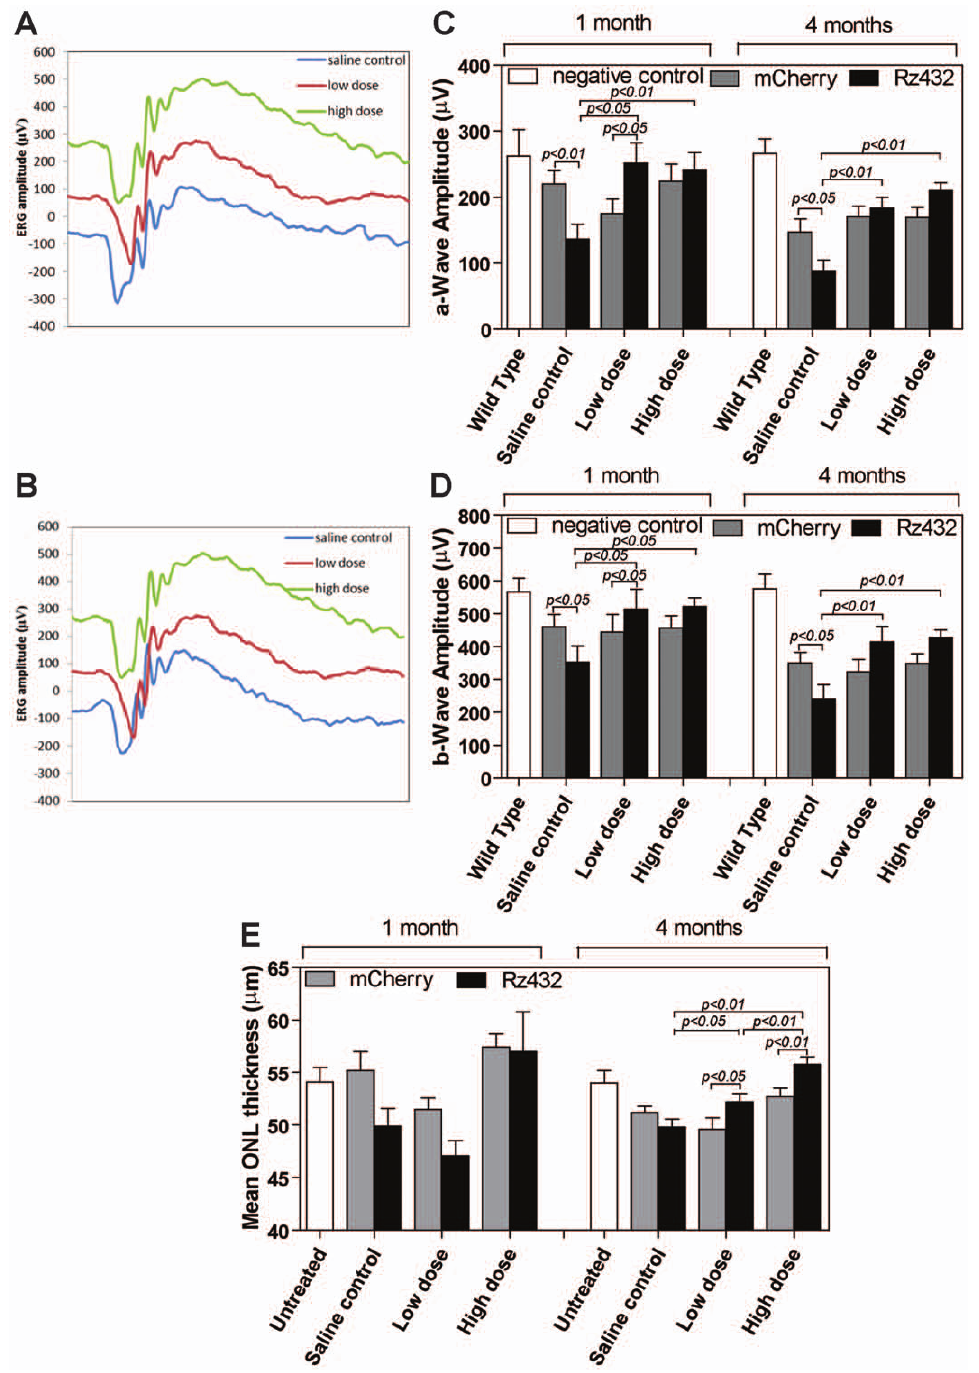
Figure 6. ERG a-wave and b-wave amplitudes and retinal thickness measured in AAV-ribozyme SOD2 knockdown eyes and control eyes treated with 8-OH DPAT. Eyes received injection of AAV- SOD2 ribozyme or AAV-mCherry and animals received subcutaneous 8-OH DPAT or saline control for up to 4 months. ERGs were obtained at 1 and 4 months following virus injection: A & B - ERG wave-forms from mice treated with AAV-mCherry ( A ) or AAV-VMD2- SOD2 Rz ( B ). Simultaneous full-field ERG measurements were recorded in dark-adapted mice four months after injection with AAV. The scale units on the ordinate are 100 microvolts. The graphs show wave forms for mice treated with saline, blue lines, low dose (0.5 mg/kg) 8-HO-DPAT, red lines, or high dose (5 mg/kg) 8-HO-DPAT, green lines. C – a-wave; D – b-wave. E - ONL thickness measured by SD-OCT at 1 and 4 months. Untreated wild type animals acted as the baseline control. (10 animals per group, P # 0.01 for all doses and time points).